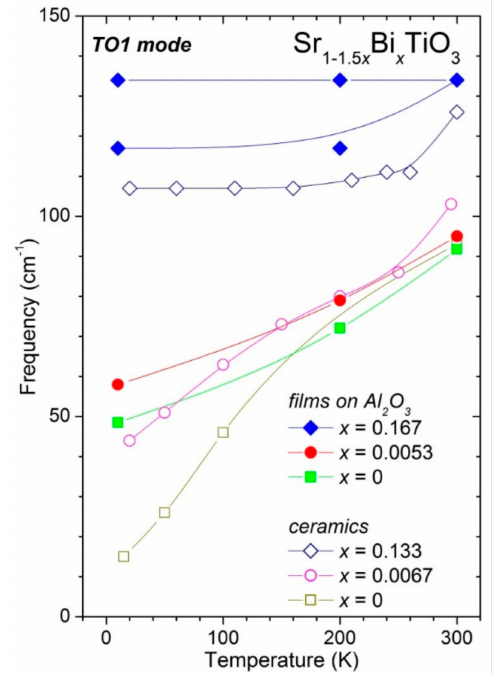
Figure 5. Temperature dependence of the TO1 mode frequency in Sr 1 − 1.5x Bi x TiO 3 thin films with x = 0, 0.0053 and 0.167 deposited on Al 2 O 3 substrates in comparison to that of undoped and Bi-doped ST ceramics with x = 0.0067 and 0.133 [27,39]. The lines are guides for the